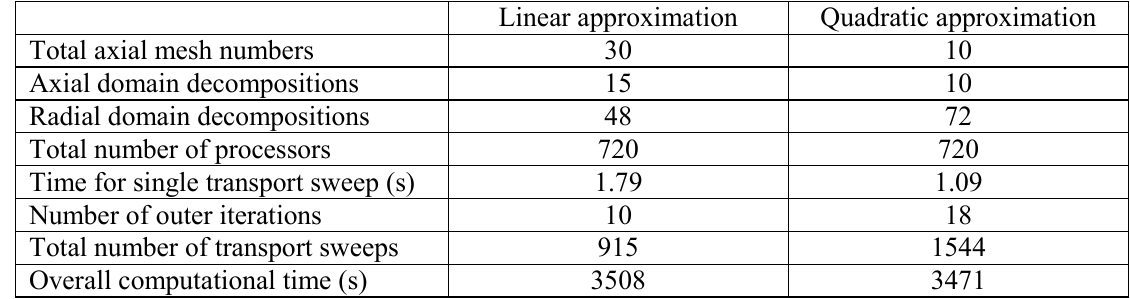
Table II. Comparison of Computational performance of linear and quadratic approximations for comparable accuracy.